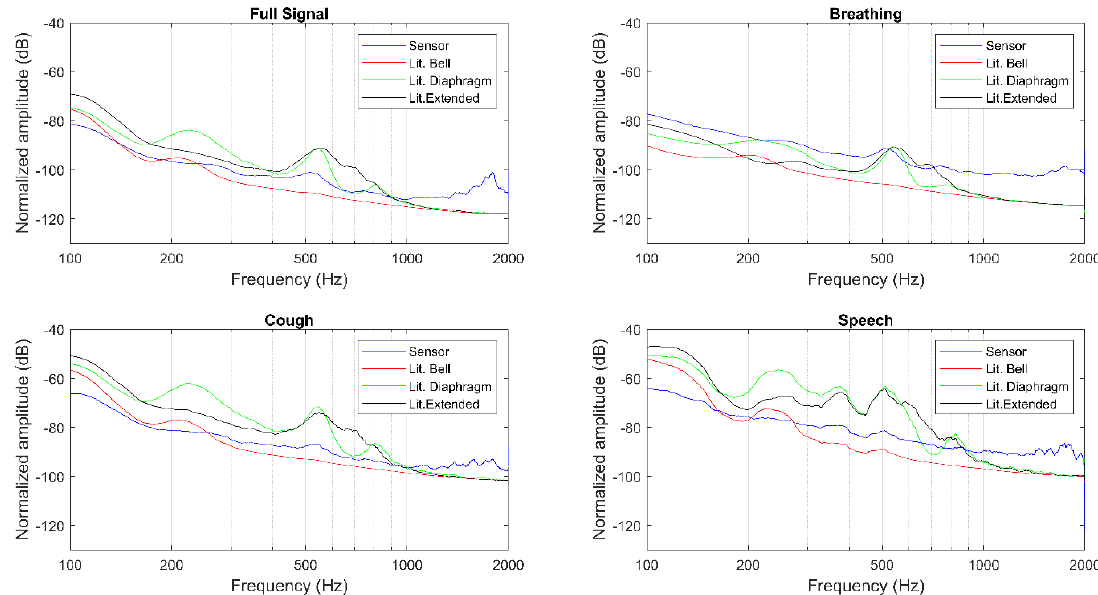
Figure 7. Magnitude spectra for position 7.